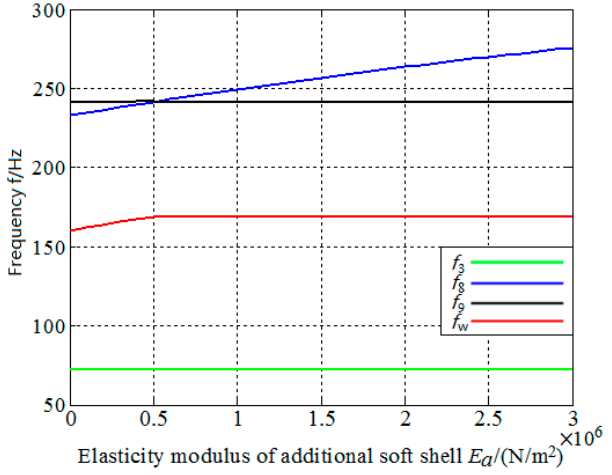
Figure 9. Band structures of LRPC DPSs if the elasticity moduli of the soft shell are ( a ) E a = 1 × 10 6 N/m 2 and ( b ) E a = 2 × 10 6 N/m 2 , respectively.